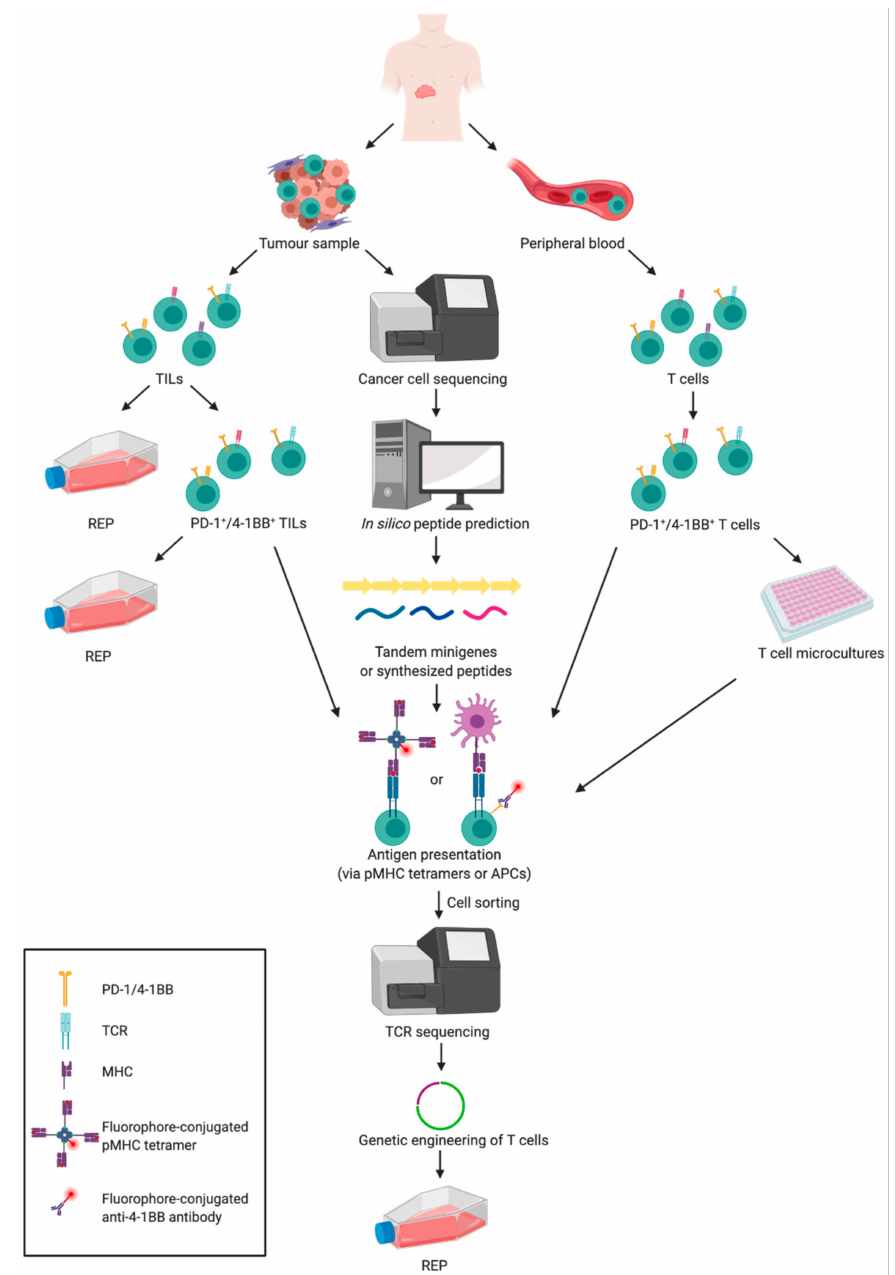
Figure 2. Strategies for T cell selection for adoptive cell therapy (ACT) of cancer. Resected tumour and peripheral blood samples are two main sources of T cells for ACT of cancer. Tumour samples require processing to obtain tumour infiltrating lymphocytes (TILs). Heterogenous TIL population can be expanded according to the rapid expansion protocol (REP). Alternatively, TILs expressing programmed death receptor 1 (PD-1) or 4-1BB can be selected, to increase frequency of tumour-specific T cells, which are subsequently expanded. Another approach includes cancer cell sequencing followed by in silico peptide prediction and tandem minigenes (TMGs) or synthetic peptide generation. Subsequently, T cells isolated from cancer patient, after optional enrichment for PD-1 + / 4-1BB + cells, are tested for reactivity to predicted neopeptides with one of the following approaches: binding to MHC tetramers loaded with synthetic peptides (pMHC tetramers); and expression of activation marker (e.g., 4-1BB) in the presence of APCs transfected with TMGs or pulsed with synthetic peptides. Then, antigen-specific T cells are sorted and their TCRs are sequenced in aim to introduce tumour-specific TCRs into polyclonal T cells. Subsequently, TCR-engineered T cells are expanded for therapeutically relevant numbers (the figure was created with